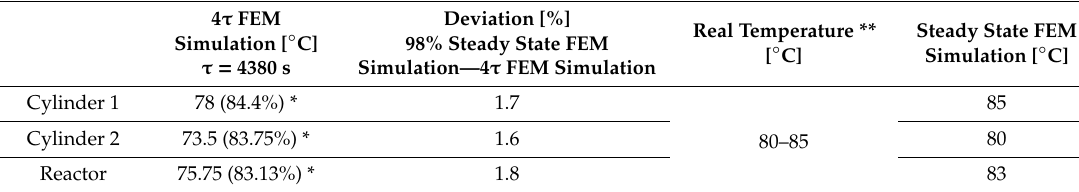
Table 9. Multiphysics model